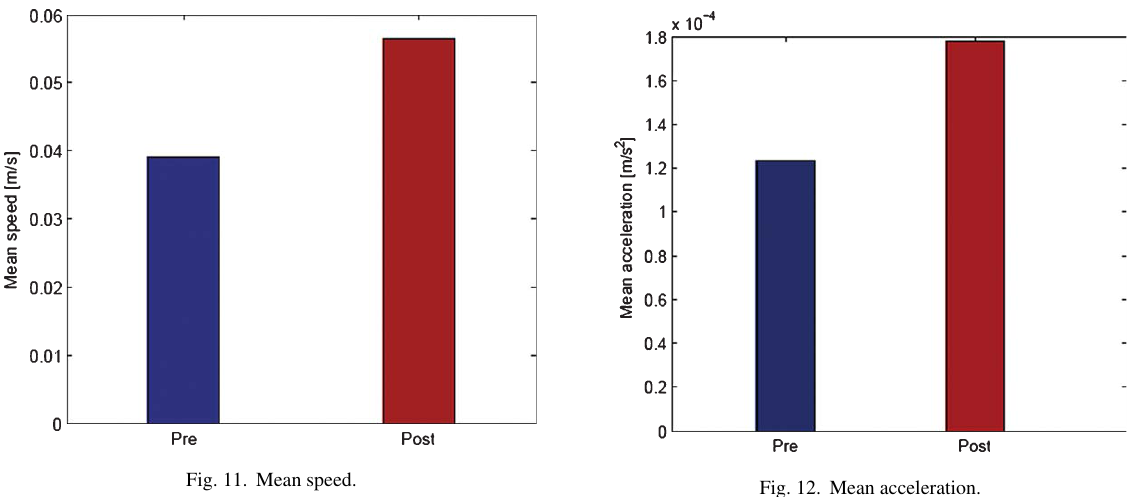
Fig. 10. Subjects’s values of parameter Max ( (cid:1) F ) for direction N t , in P H , P PSPRE and P PSPOST (Y-axis units: